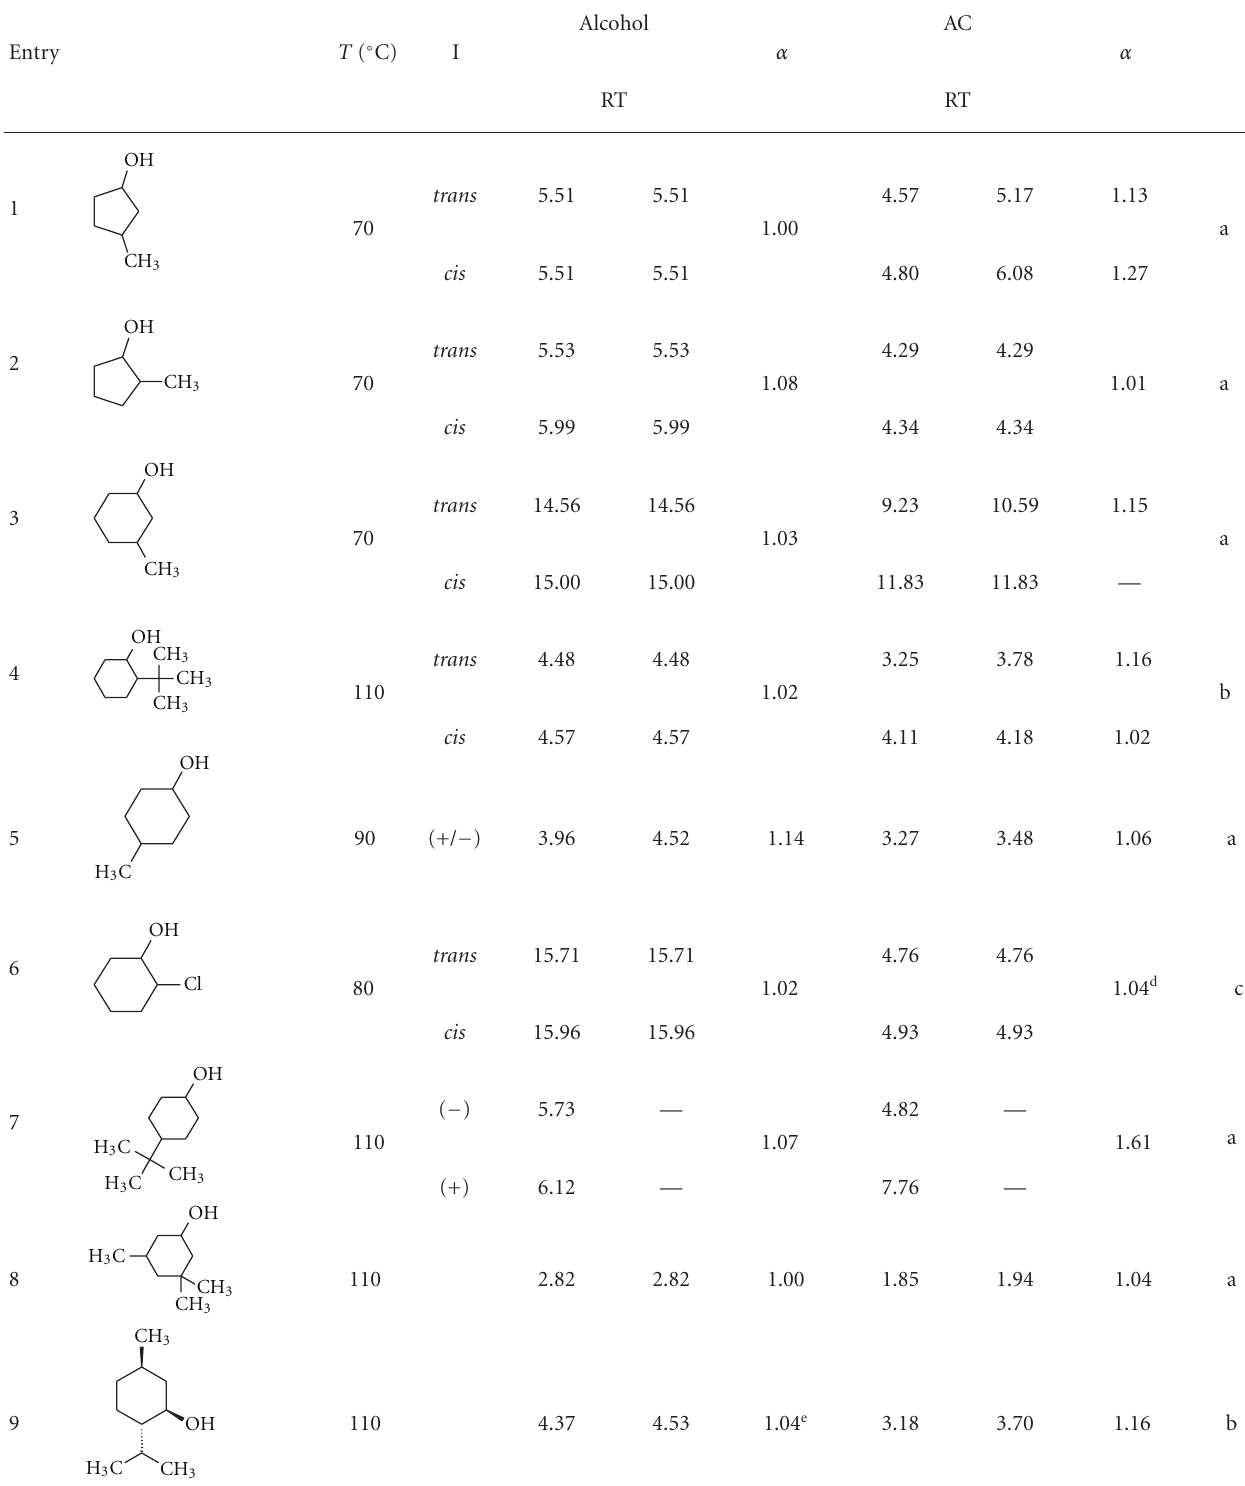
Table 5: Separation factor values ( α ) of the stereoisomers of some cyclic alcohols and their corresponding acetyl derivatives.